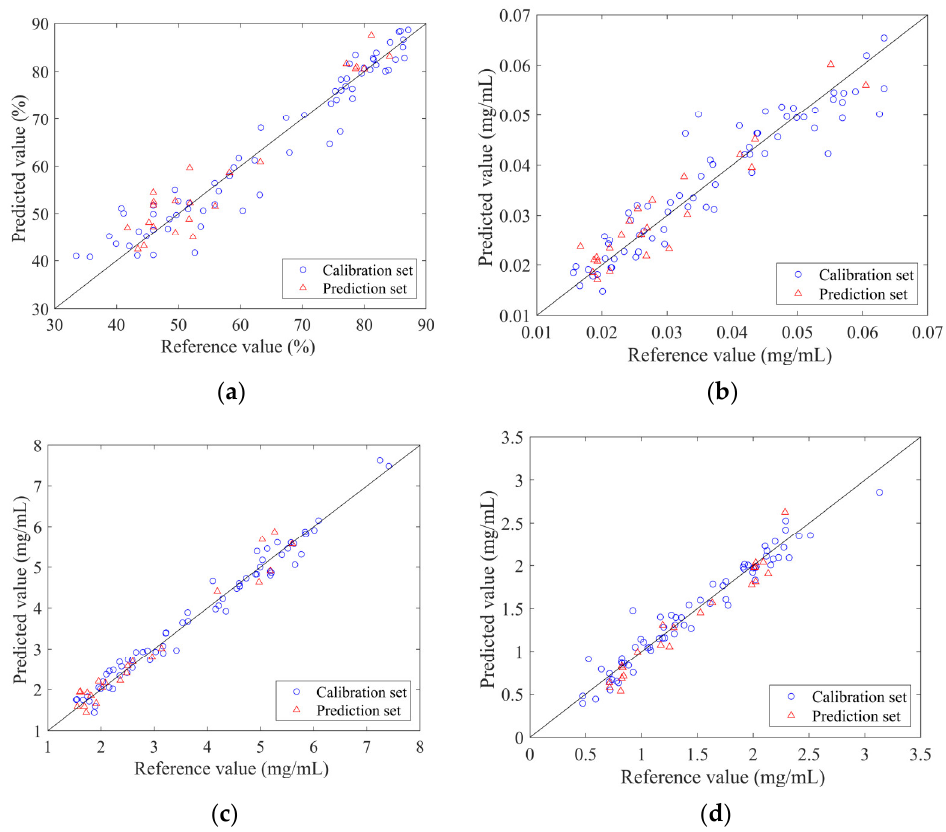
Figure 6. Scatter plot of reference measurements and NIR predictions using the optimal non-invasive PLSR model.: ( a ) ANTI-NO; ( b ) epigoitrin; ( c ) geniposide; ( d ) baicalin. Table 4. The results of external validation of traditional models.